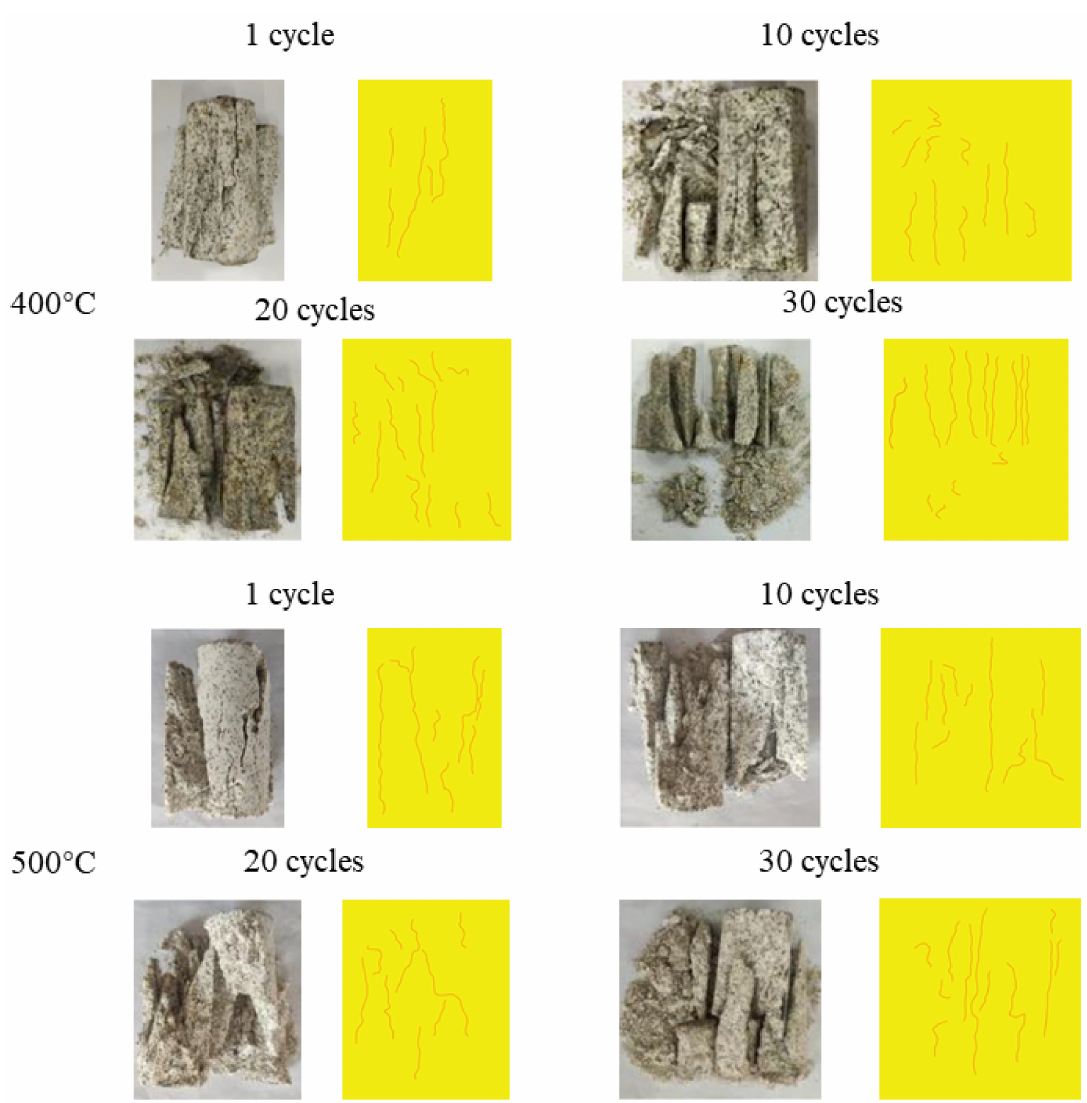
Figure 8. Failure mode and geological sketches of granite (left and right images are original failure pictures and geological sketch pictures,